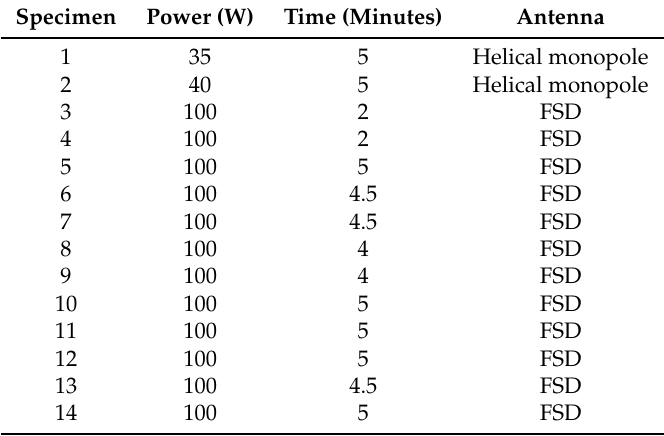
Table 1. Power level, duration, and antenna type used for each ablation experiment. Specimen Power (W) Time (Minutes) Antenna 1 35 5 Helical